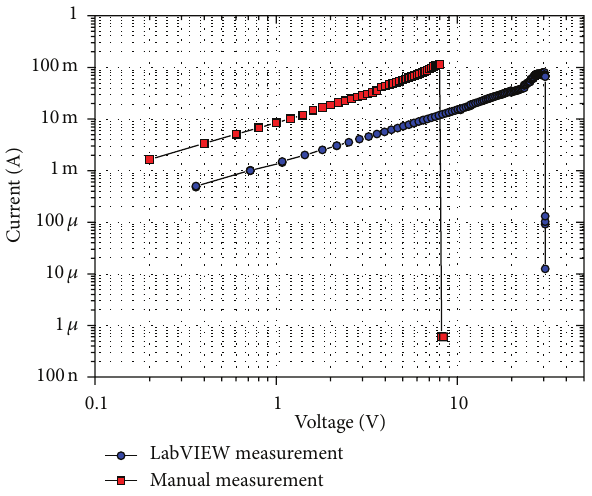
Figure 3: I-V characteristics of 1 micrometer layer of NG film on quartz substrate.